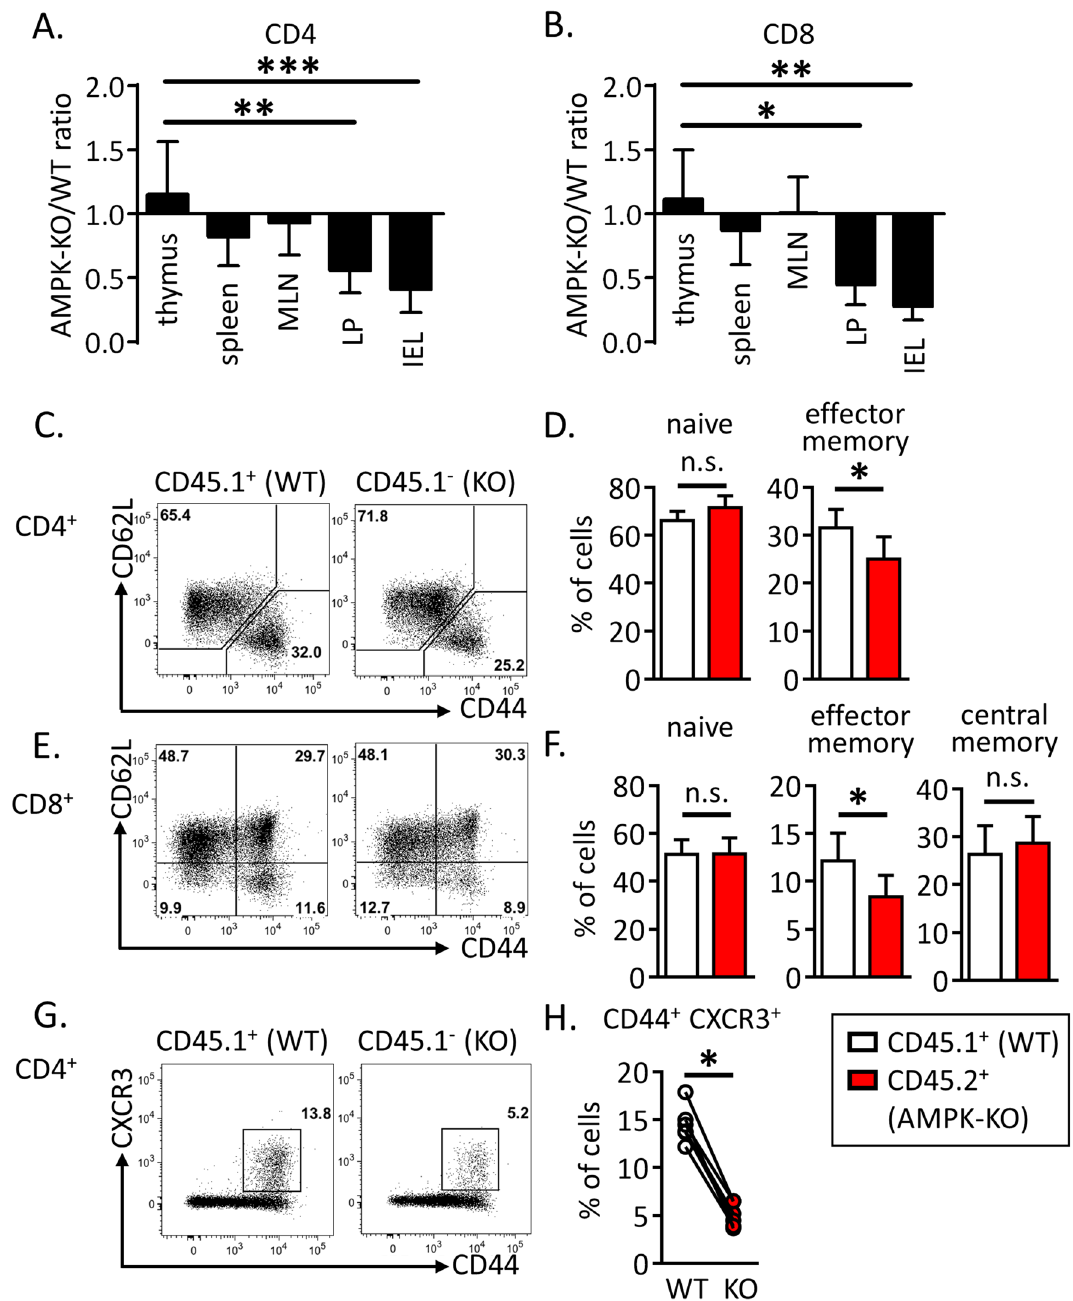
Figure 1. AMPK promotes peripheral T cells replenishment upon bone marrow transfer. ( A , B ) Relative contribution of AMPK-KO CD4 + ( A ) and CD8 + ( B ) T cells in the thymus, spleen, MLN, LP and IEL of CD3ε −/− mice reconstituted with a 1:1 mixture of bone marrow cells from WT (CD45.1) and AMPK KO-T (CD45.2) mice. Data are expressed as a ratio of AMPK-KO over WT cells in the CD4 + or CD8 + T cell gate. ( C – H ) CD62L, CD44 and CXCR3 expression by WT and AMPK-KO T cells recovered from the spleen of mice reconstituted as in ( A , B ). Representative dot plots ( C , E ) and histograms showing the mean % ± SD ( D , F ) in different cell gates as indicated. Data are representative of 3 ( A , C , D , G , H ) or 2 ( B , E , F ) independent experiments with n = 6. Statistical analysis: Friedman followed by Dunn multiple comparison ( A , B ), Mann–Whitney ( D , F ), Wilcoxon Test ( H ). *p < 0.05 ; **p < 0.01 ; ***p < 0.001. MLN mesenteric lymph nodes, LP lamina propria, IEL intra- epithelial